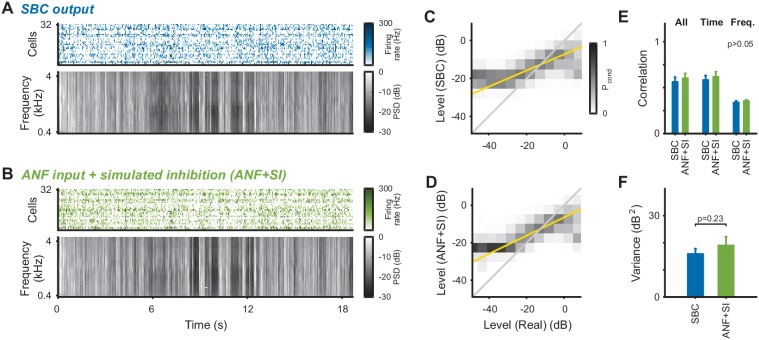
For certain postsynaptic response properties, the effect of inhibition appears to be accounted for well by activity-dependent subtractive inhibition (Figure 2, and Keine et al., 2016).We compared the stimulus reconstruction between the experimental SBC output and the ANF input subject to same subtractive inhibition as in Figure 2 (ANF + SI, see Materials and methods for details). (A) SBC responses and reconstructed spectrogram, same as Figure 3E, provided for direct comparison. (B) Subtractive inhibition applied to the ANF responses (ANF + SI) leads to similar responses and reconstructed spectrogram as for the SBC responses. (C) Joint histogram of reconstructed levels from SBC responses compared with the real levels (as in Figure 3H). (D) Joint level histogram comparing the ANF + SI to the real levels, take a similar shape with almost identical slope compared to the SBC responses. However, SBC responses have an even more restricted dynamic range for low levels. (E) Reconstruction quality measured by correlation coefficients did not differ significantly between SBC and ANF + SI for either total, time or frequency correlations (all p>0.05). (F) Variance of the reconstructed stimulus for ANF + SI was comparable to the experimental SBC output (p=0.23).